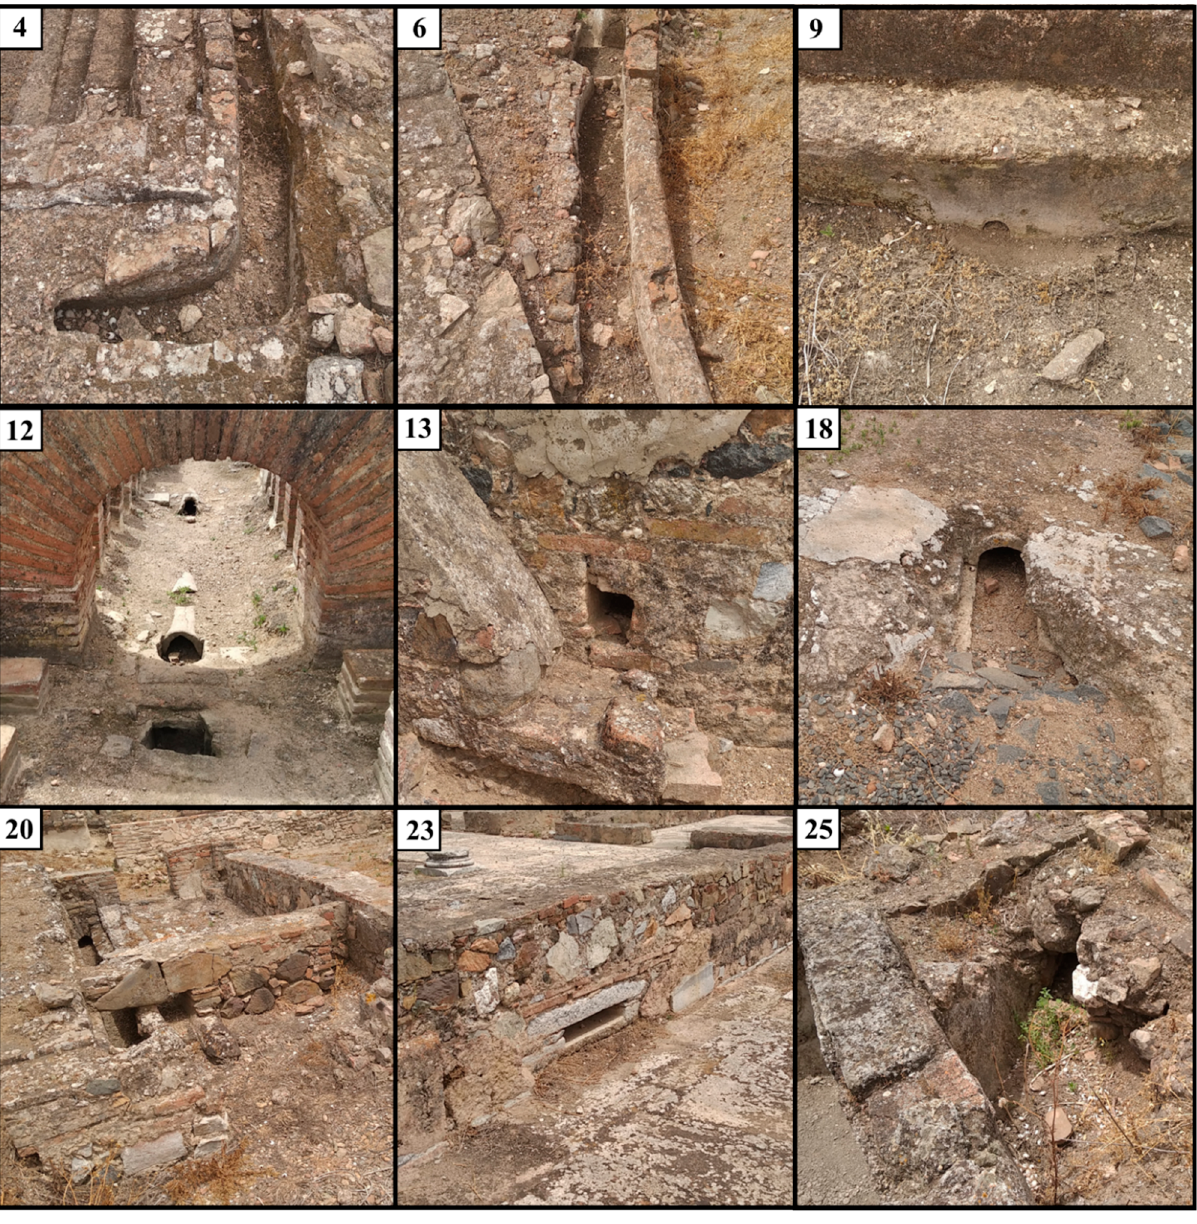
Figure 4. Examples of water conduits of Pisões. The numbering corresponds to the structures identified in Figure 3.